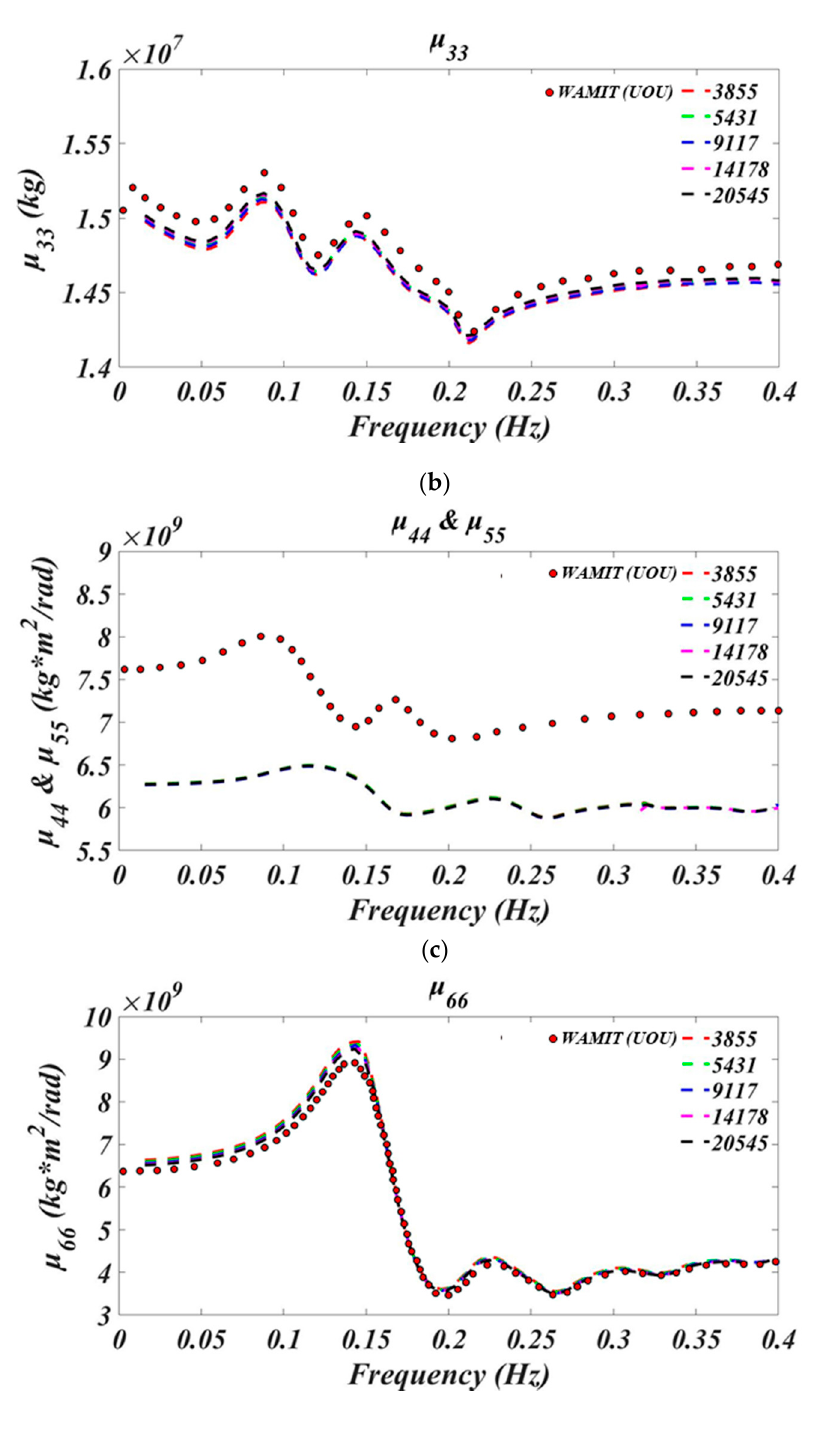
Figure 8. The comparison of added-mass coefficients between different mesh numbers and the UOU data in ( a ) surge and sway, ( b ) heave, ( c ) roll and pitch, and ( d ) yaw modes.